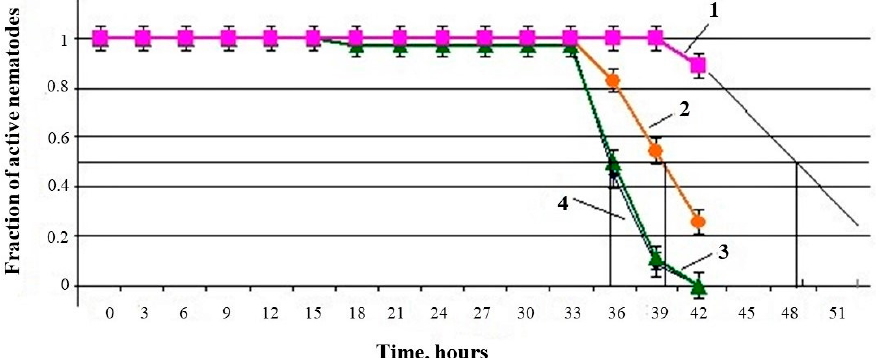
Figure 3. Changes in the median lifespan of nematodes with time in the presence of different concentrations of U. dermestoides extract: (1, predicted value) 10% of the total sample volume; (2) 2.5%; (3) 1%; (4) control.